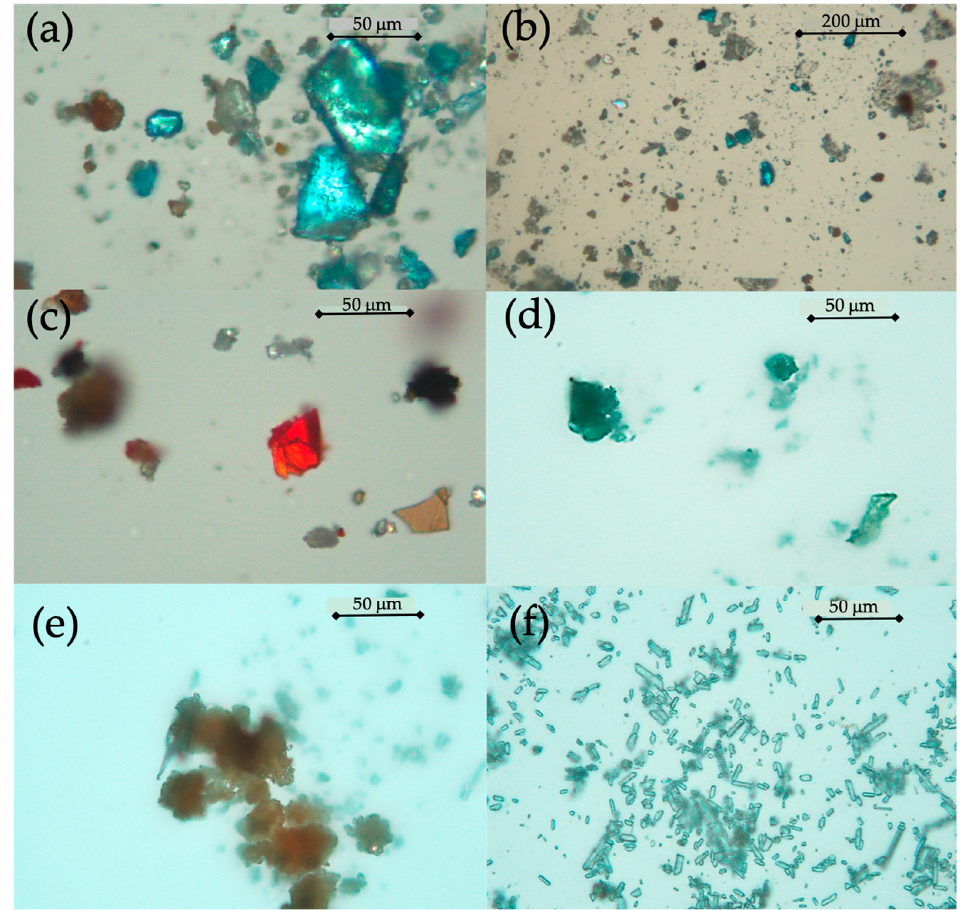
Figure 3. Microphotograph of the pigments identified in the 10 samples analyzed taken in plane-polarized transmitted light: ( a ) azurite (sample K-4); ( b ) azurite and accessory minerals (sample K-4); ( c ) cinnabar (sample C-2); ( d ) indigo (sample D-1); ( e ) orpiment (sample D-1); ( f ) gypsum (sample J-4).